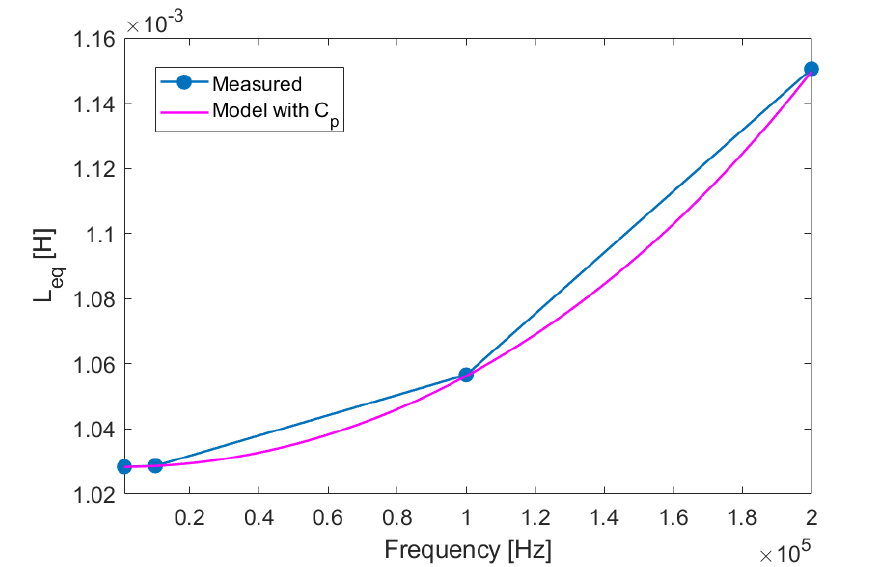
Figure A1. Measured inductance of an RX coil (blue) and its model given by Equation (A1)